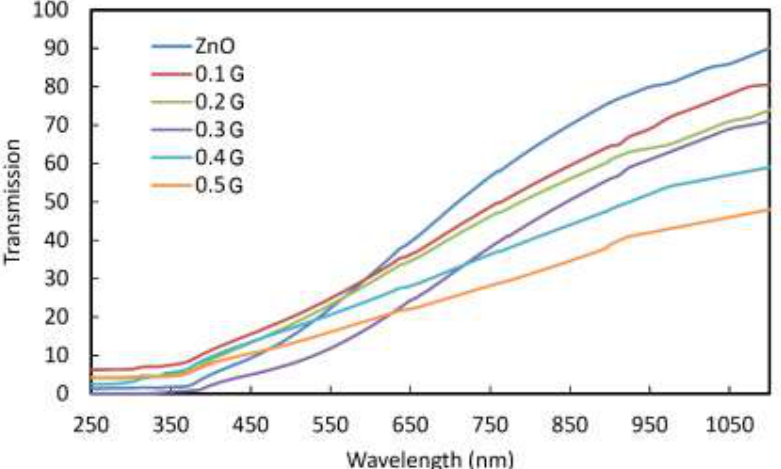
Figure 3: UV–Vis Transmission spectra of the nanohybrid graphene-ZnO thin films with different concentrations.